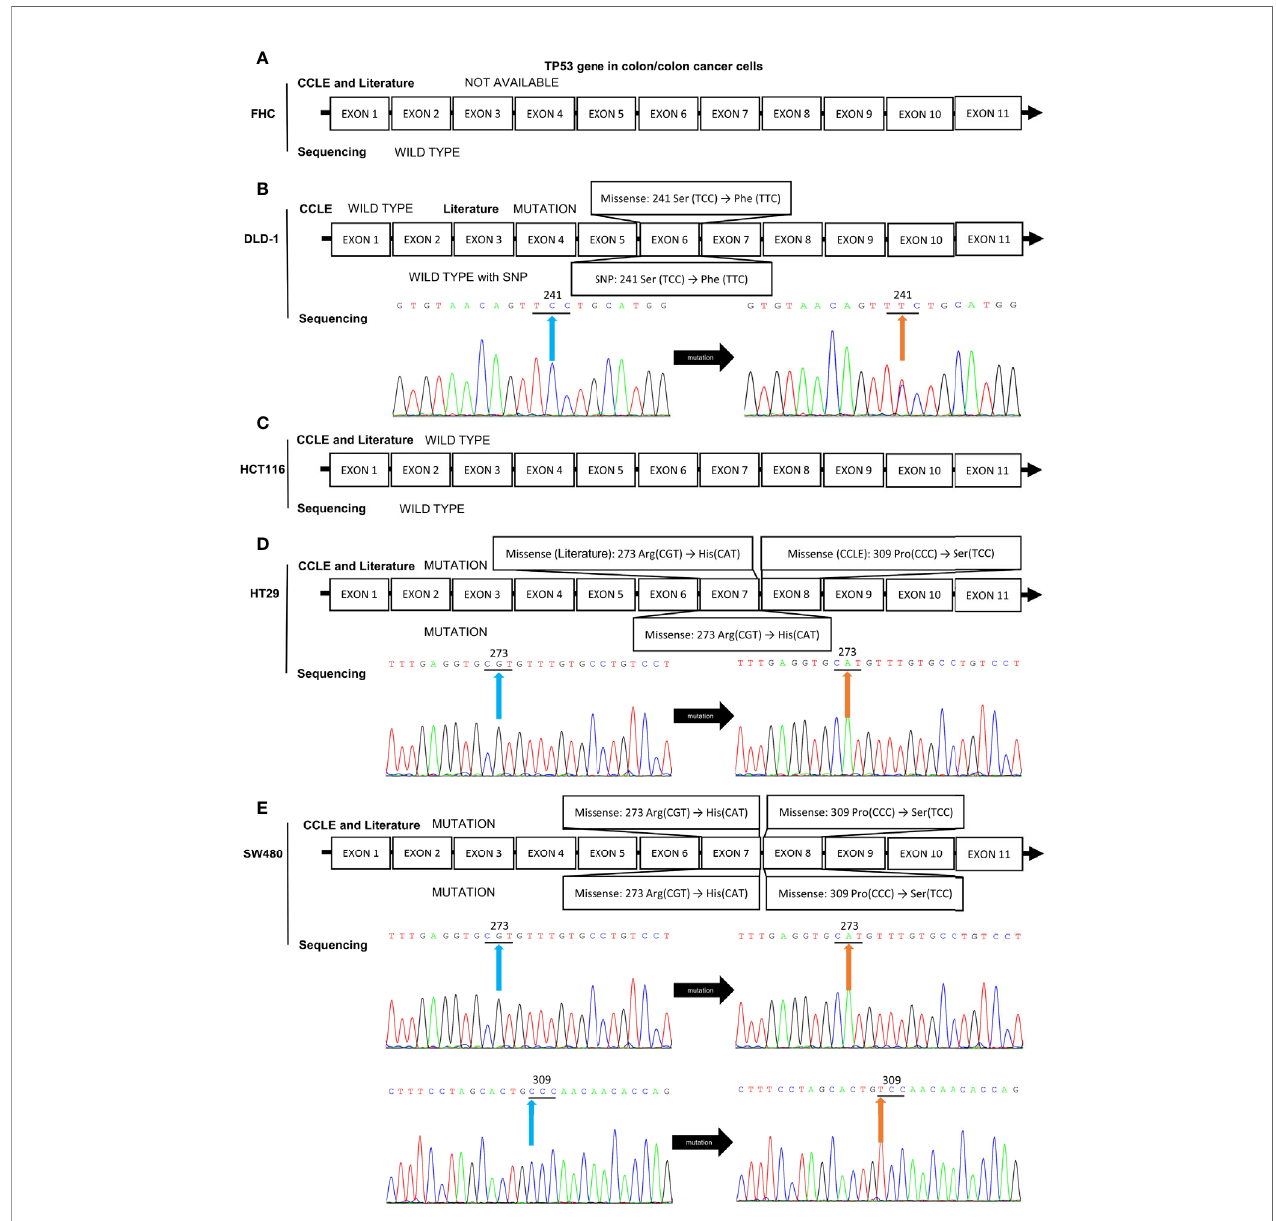
FIGURE 8 | Mutation analysis of the TP53 gene in CRC cell lines by reviewing literatures, retrieving data in CCLE database, and DNA sequencing analysis. The mutational status of TP53 gene in (A) FHC, (B) DLD-1, (C) HCT116, (D) HT-29, and (E) SW480 cell lines. The blue and orange arrows indicate the locations of the mutation